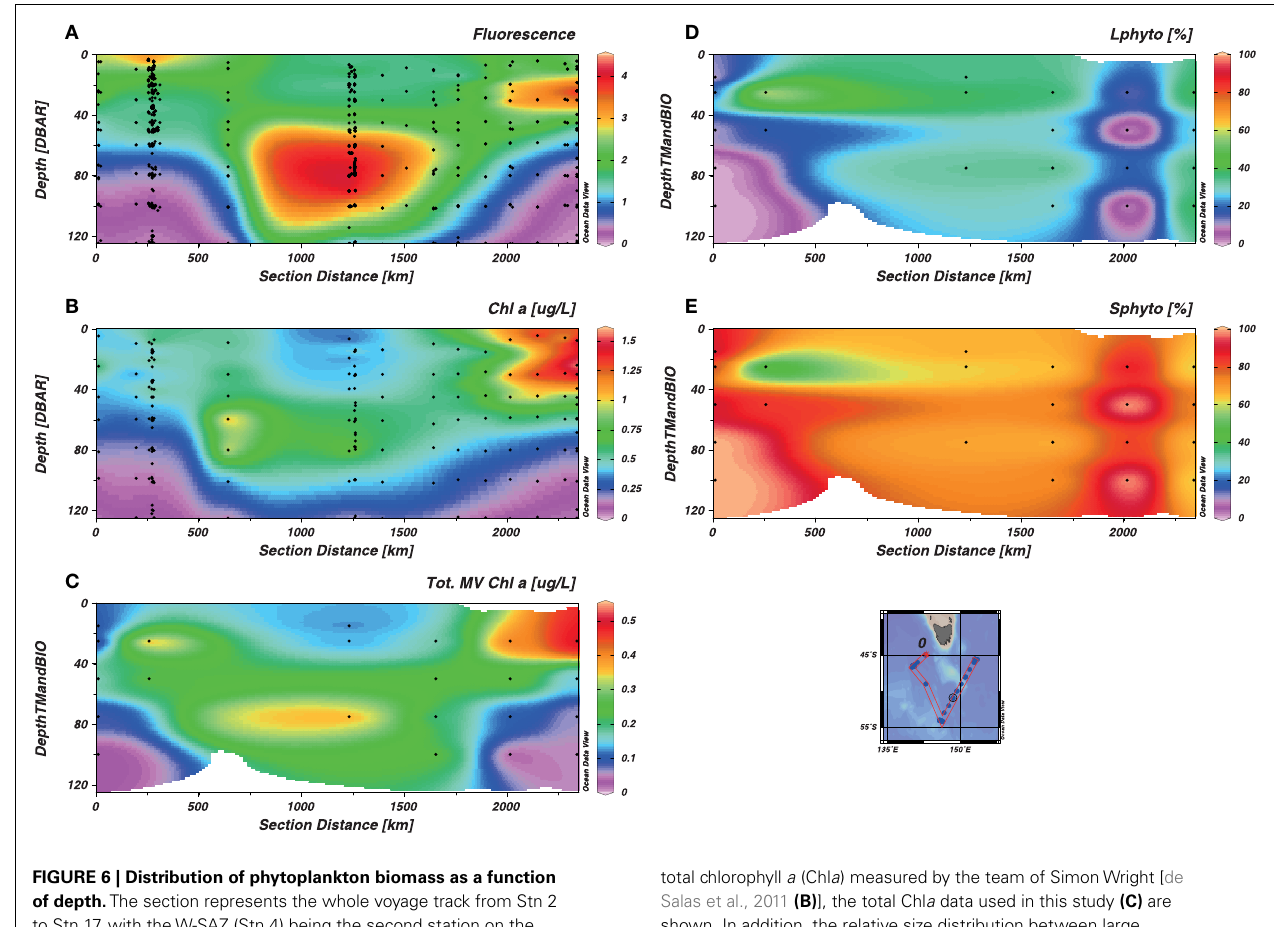
FIGURE 6 | Distribution of phytoplankton biomass as a function of depth. The section represents the whole voyage track from Stn 2 to Stn 17, with theW-SAZ (Stn 4) being the second station on the left, the PFZ (Stn 6) in the center and the E-SAZ (Stn 17) the last on the right.The fluorescence from the CTD [CTDFLUORO (A) ], the